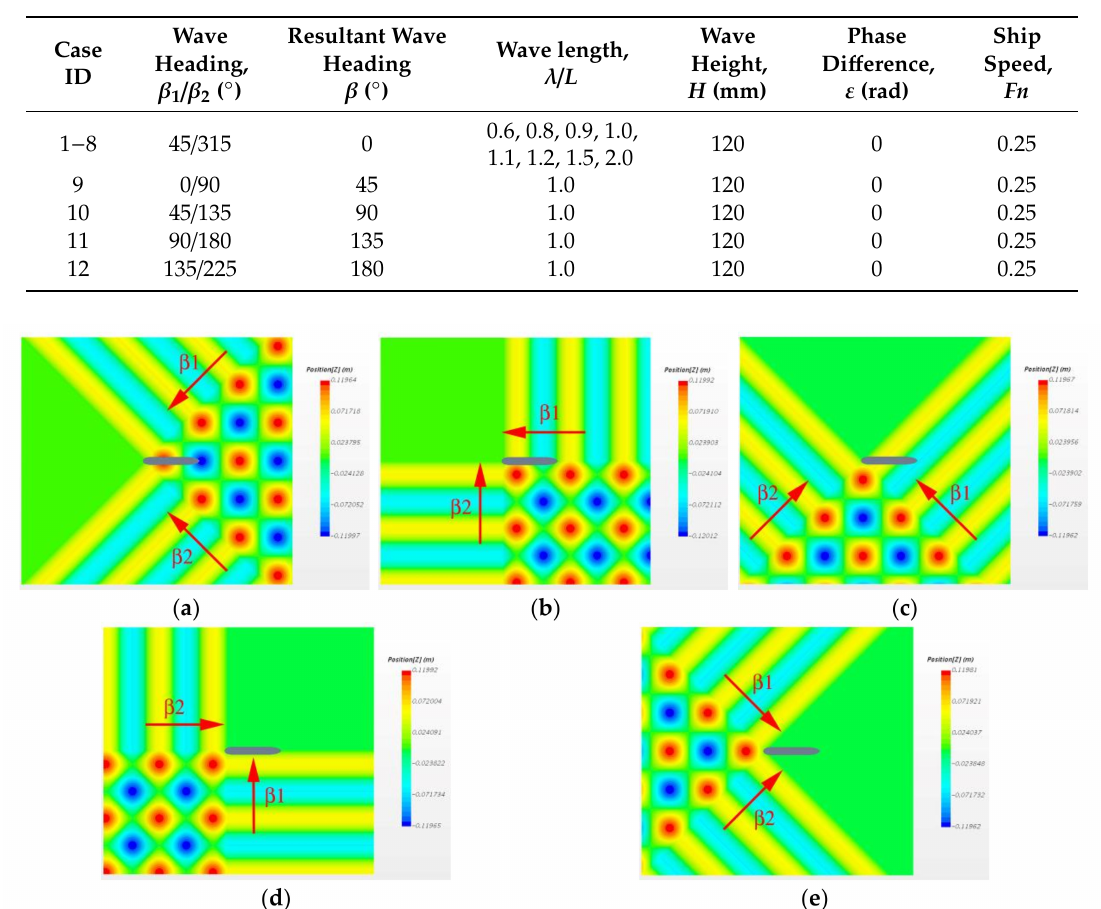
Table 2. Numerical simulation conditions.